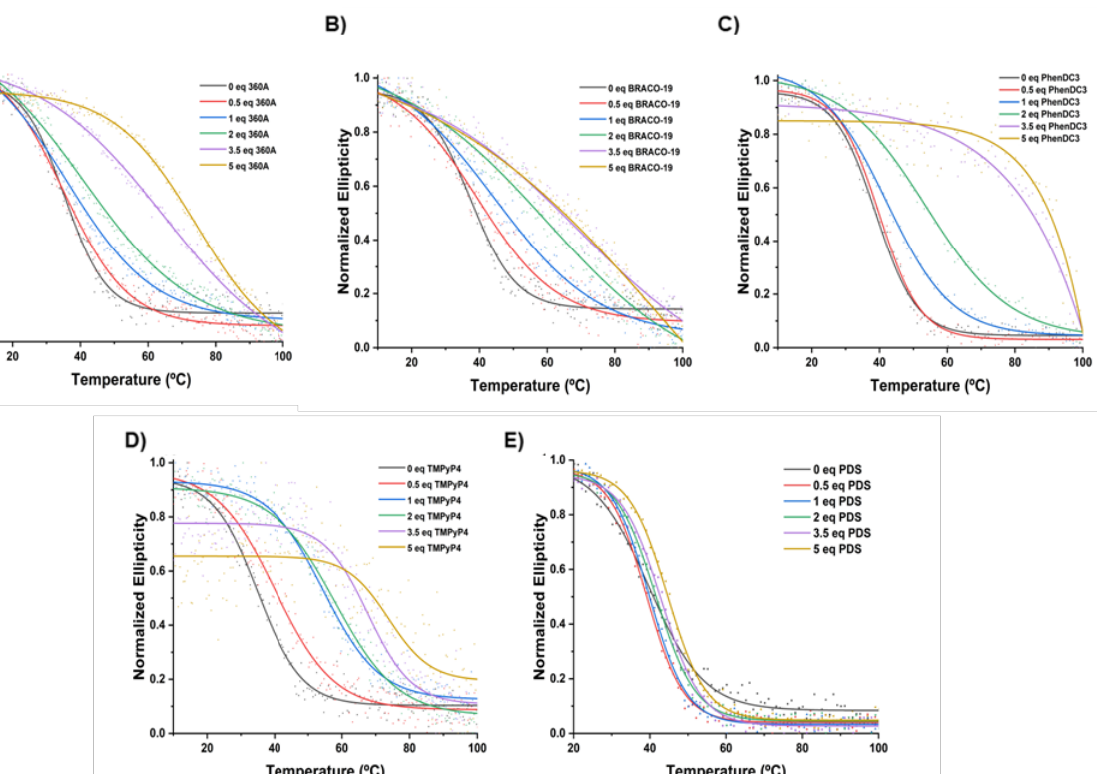
Figure 5. T m radar plot of AT11-L2 in the presence of different molar equivalents of tested ligands obtained by CD-melting experiments .